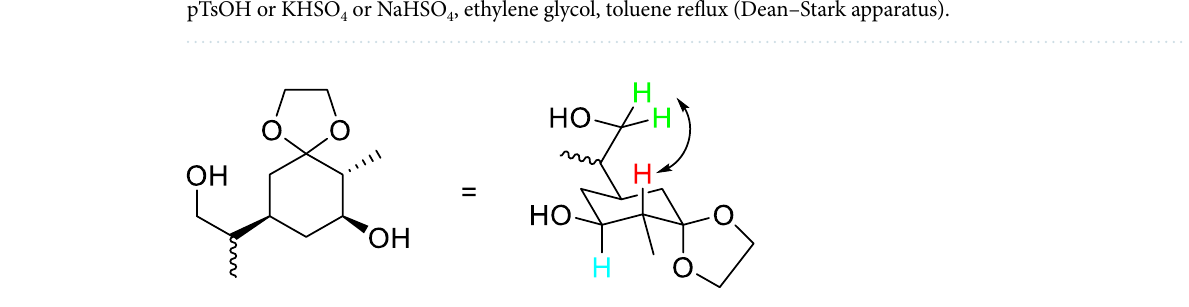
Figure 1. Synthetic approach to carbasugar precursors. (a) polyaniliniumsulfate, ethylene glycol, toluene, reflux (Dean–Stark apparatus); ( b ) BH 3 *THF, 2,3-Dimethyl-2-butene; ( c ) H 2 O 2 /NaOH; ( d ) KMnO 4 , MgSO 4 , H 2 O; ( e ) pTsOH or KHSO 4 or NaHSO 4 , ethylene glycol, toluene reflux (Dean–Stark apparatus).